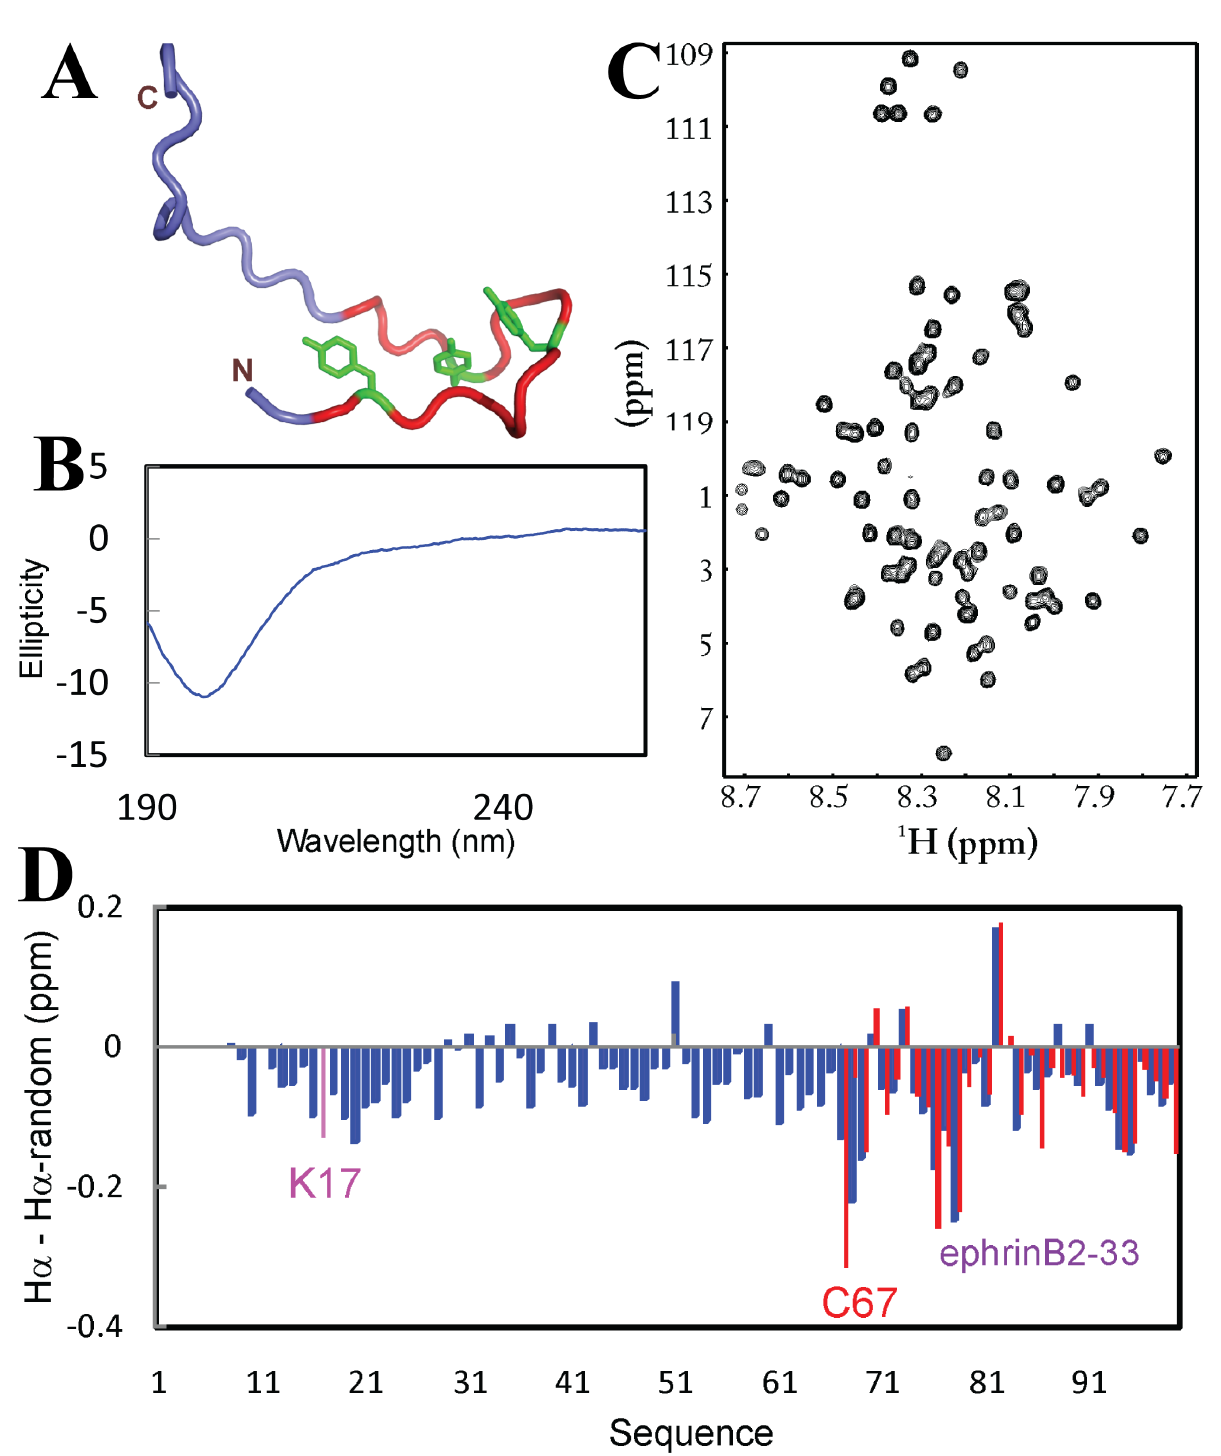
Figure 15. Conformations of the entire cytoplasmic domain of ephrin-B2 (83 residues) solubilized in unsalted water. ( A ) Three- dimensional structure of the last 33 residues designated as ephrinB-33 that we previously determined by NMR spectroscopy. ( B ) Far-UV CD spectrum of the entire ephrin-B2 cytoplasmic domain at a protein concentration of 20 µM (pH 4.0) at 25 ° C. ( C ) 1 H– 15 N NMR HSQC spectrum at a protein concentration of 300 µM (pH 4.0). ( D ) H α conformational shifts of the entire ephrin-B2 cytoplasmic domain with a 16-residue His-tag (blue bars) and of the isolated last 33 residues ephrinB-33 (red bars). The first 7 residues of the His-tag could not be assigned due to missing side-chain resonances. Lys17 is the starting residue of the entire cytoplasmic domain while Cys67 is the starting residue of ephrinB-33.